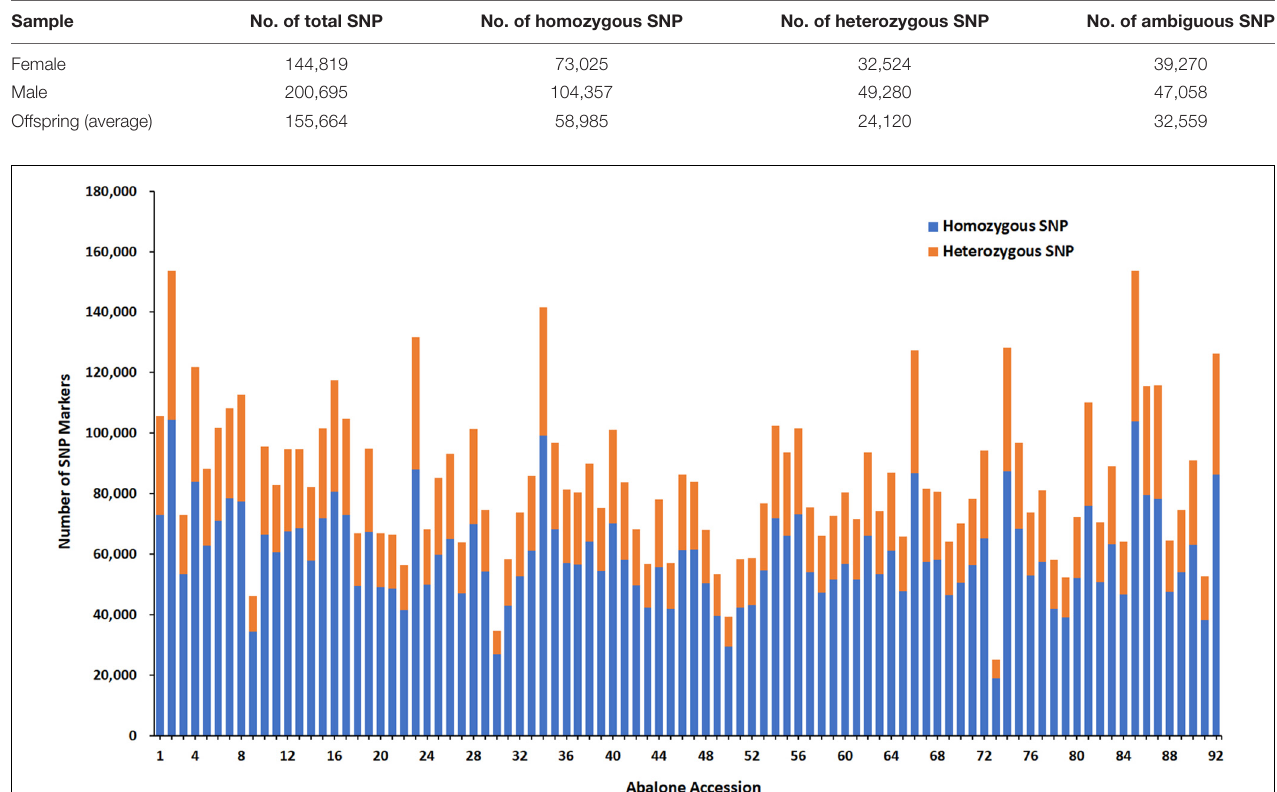
TABLE 4 | Summary of SNPs detected in parents and progenies of Pacific abalone.